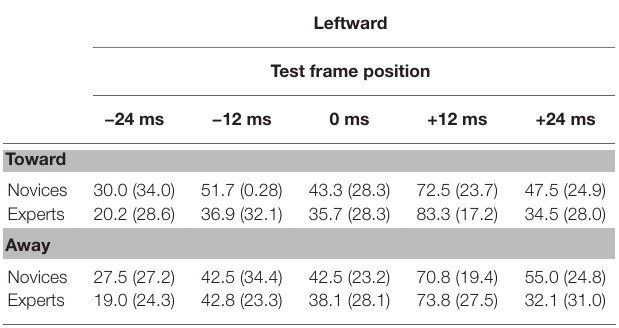
TABLE 1 | Weighted means (and standard deviations) for each group in each experimental condition. Bold font values indicate expert values that are significantly different from respective novice values.